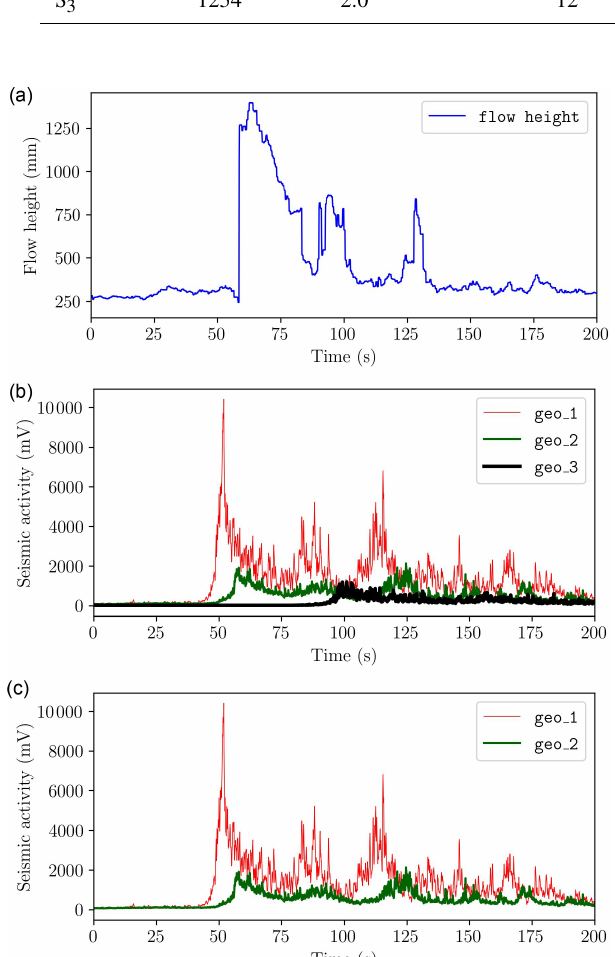
Figure 4. Overview of a recording of an event for station S 1 ; geo_X labels represent geophone signals: (a) flow height sensor, (b) full record of the geophone signal and (c) chosen signals.